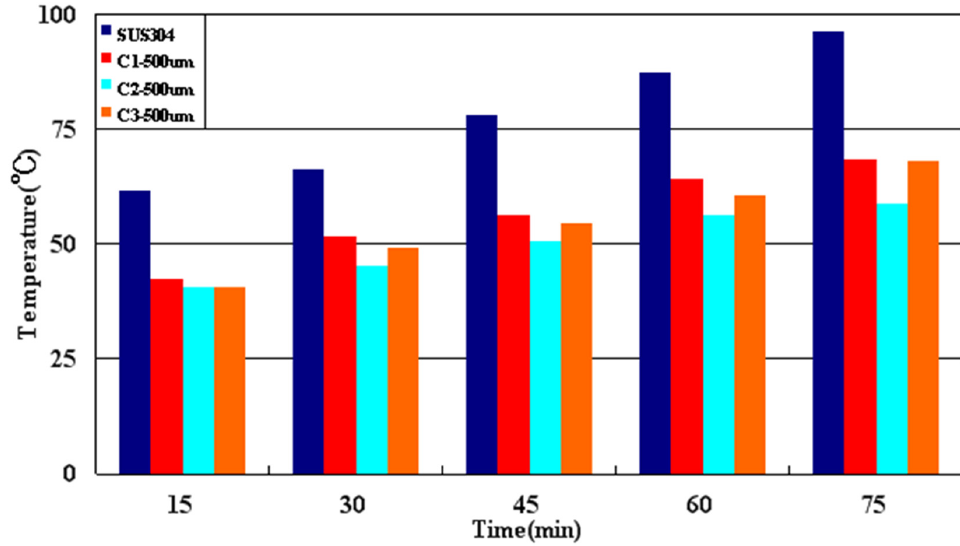
Figure 11. The temperature change analysis diagram of the center point of the SUS304 surface and coating surface of 500 μ m C.